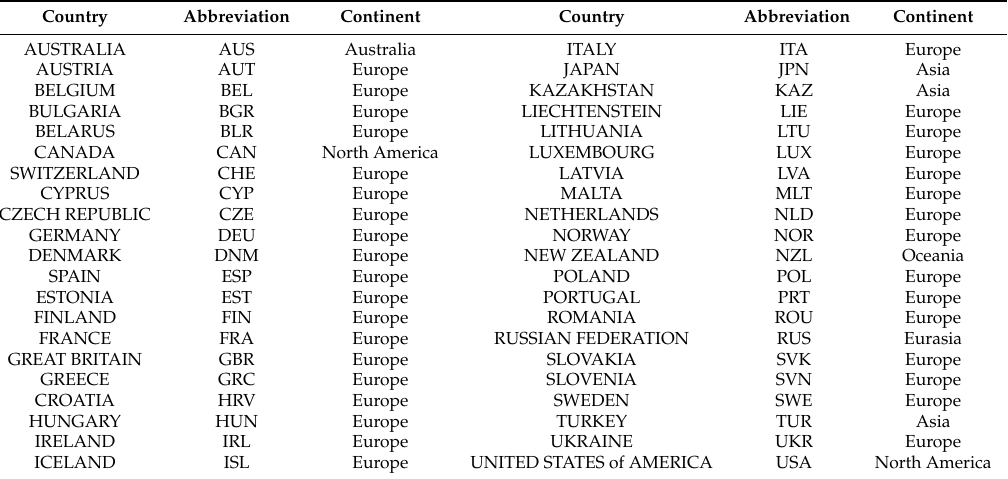
Table 1. Annex I countries, their abbreviations and geographic